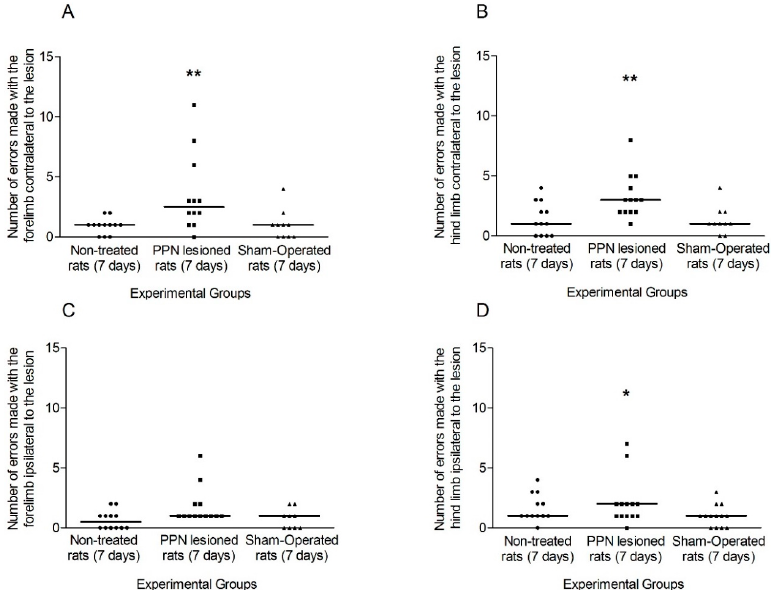
Figure 6. Comparison of the faults made by each limb separately during the execution of Grid Test seven days after pedunculopontine nucleus lesion. ( A ) Faults made by the contralateral forelimb (H (2,38) = 10.91 p < 0.01). ( B ) Faults corresponding to contralateral hind limb (H (2,38) = 6.71 p < 0.05). ( C ) Faults made by the ipsilateral forelimb (H (2, 38) = 3.81 p > 0.05) ( D ) Faults corresponding to ipsilateral hind limb (H (2, 38) = 8.45 p < 0.05). Kruskal–Wallis test. * p < 0.05, ** p < 0.01. The points represent the number of errors of each experimental subject. The horizontal lines represent the medians of each sample.